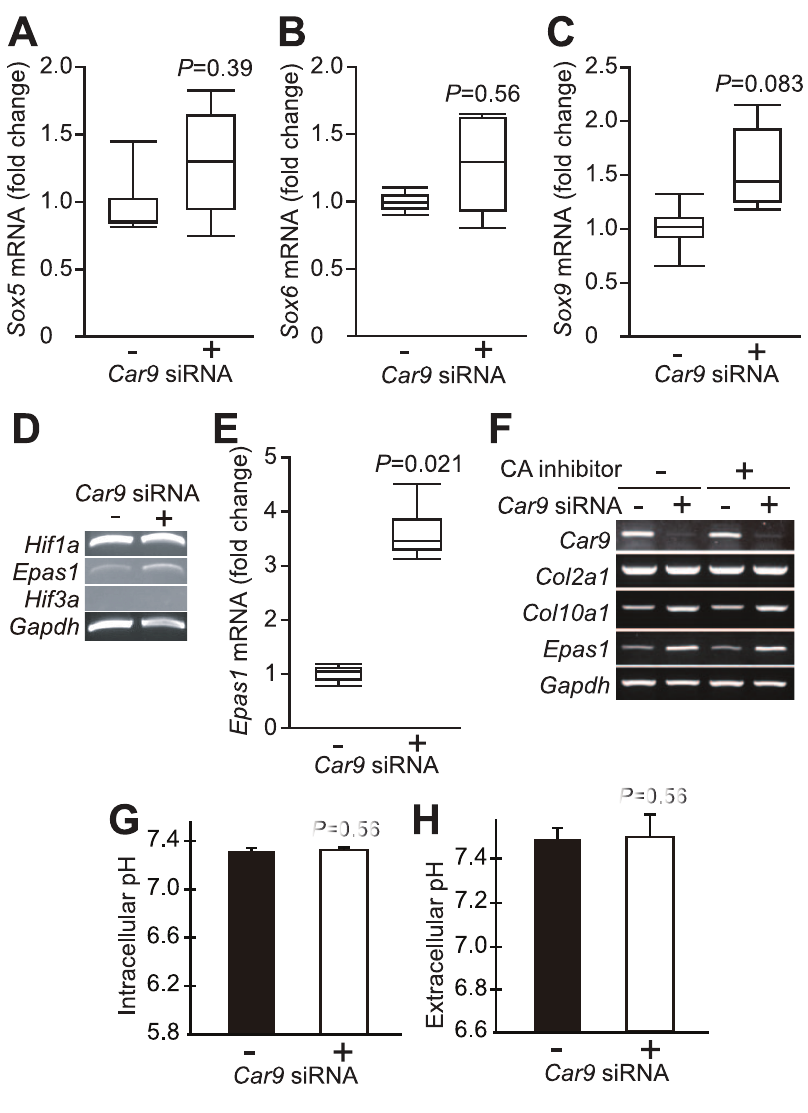
Figure 4. Effects of Car9 siRNA on expressions of transcription factors related to chondrocyte differentiation. Car9 siRNA ( + ) or control siRNA (-) was introduced into mouse primary chondrocytes. A-C. The expressions of Sox5 ( A ), Sox6 ( B ), and Sox9 ( C ) were quantitatively analyzed by real-time RT-PCR at 48 hours after introduction of the siRNAs. The expression level of each gene was normalized to that of Gapdh . Data are expressed by boxplots (n=4) for fold changes caused by introduction of Car9 siRNA (the sample maximum, the upper quartile, the median, the lower quartile, and the minimum observation). D . The expressions of mRNAs for Hif1a , Epas1 , Hif3a , and Gapdh were analyzed by RT-PCR at 48 hours after introduction of Car9 siRNA or control siRNA. E . The expression of Epas1 was quantitatively analyzed by real-time RT-PCR at 48 hours after introduction of the siRNAs. Data are expressed by boxplots F . Twenty-four hours after introduction of Car9 siRNA or control siRNA, primary chondrocytes were additionally cultured for 24 hours in the presence or absence of 50 m M 4-(2-aminoethyl)-benzenesulfonamide, an inhibitor of extracellular CAs. Then, the expressions of mRNAs for Car9 , Col2a1 , Col10a1 , Epas1 , and Gapdh were analyzed by RT-PCR. G and H . Intracellular ( G ) and extracellular ( H ) pH values were determined in primary chondrocytes at 48 hours after introduction of Car9 siRNA and control siRNA. Data are expressed as the mean 6 SD of 4 experiments. P -values determined by two-tailed Mann-Whitney U-test are indicated. effect on the expression of Col10a1 was small. H89, an inhibitor of protein kinase A (PKA), up-regulated the expression of Col10a1 mRNA in both Car9 siRNA- and control siRNA-introduced cells, while its effect on the expression of Epas1 mRNA was only marginal. On the other hand, 3-isobutyl-1-methylxanthine (IBMX), an inhibitor of phosphodiesterase (PDE), suppressed augmentation of Col10a1 expression by Car9 siRNA. LY294002, a phosphatidylinositol 3-kinase (PI3K) inhibitor, increased the basal expression level of Epas1 in control siRNA-introduced cells. Also, a Src Kinase Inhibitor I [4-(4’-Phenoxyanilino)-6,7-dimethoxyqui-